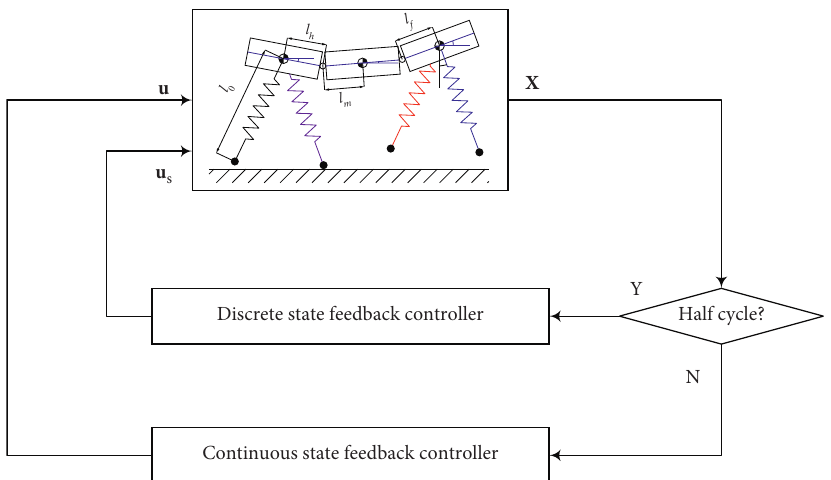
Figure 3: Control block diagram of the hybrid